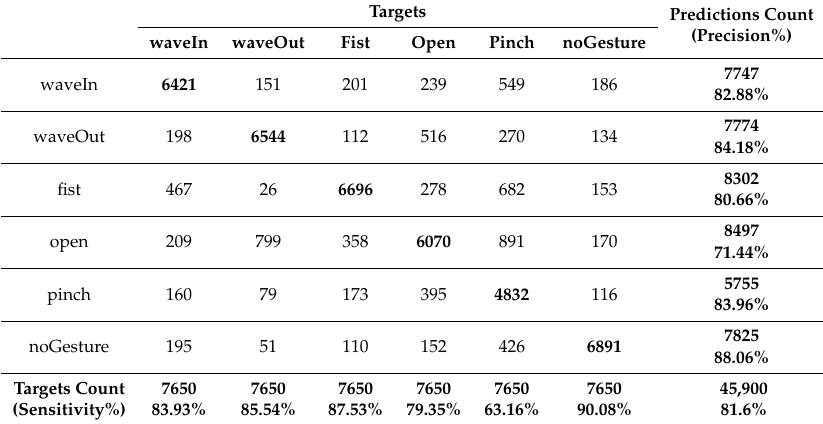
Table 7. Confusion matrix of experiment 1 for the user-general model. Rotation of the bracelet = NO , orientation correction = NO . The sync gesture was not used. Classification accuracy = 81.6%.